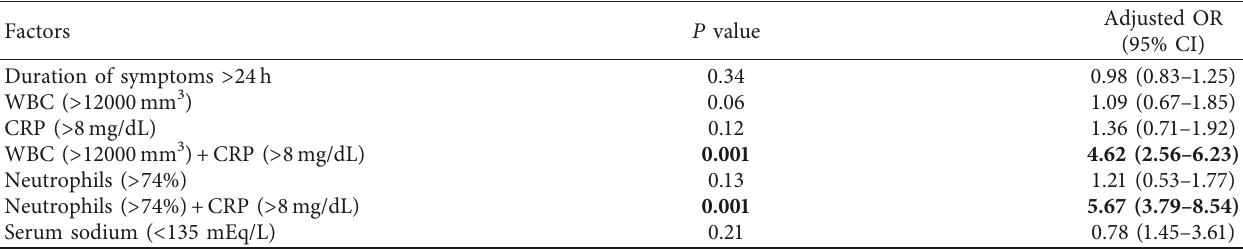
Table 4: Risk factors of perforated appendicitis in